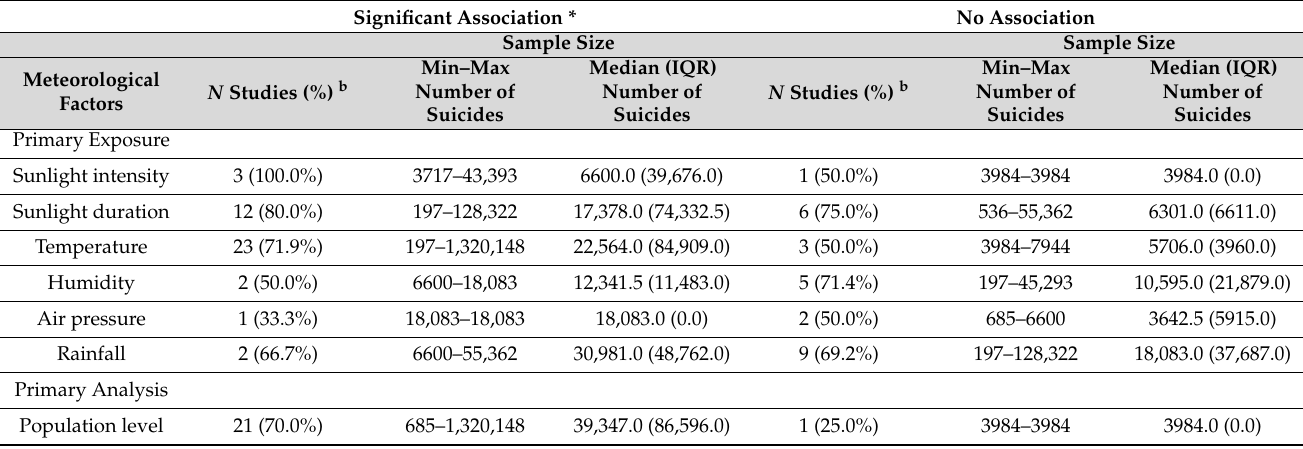
Table 3. Descriptive statistics comparing the number of suicides (i.e., sample size) in studies reporting a statistically significant ( p < 0.05) or non-significant